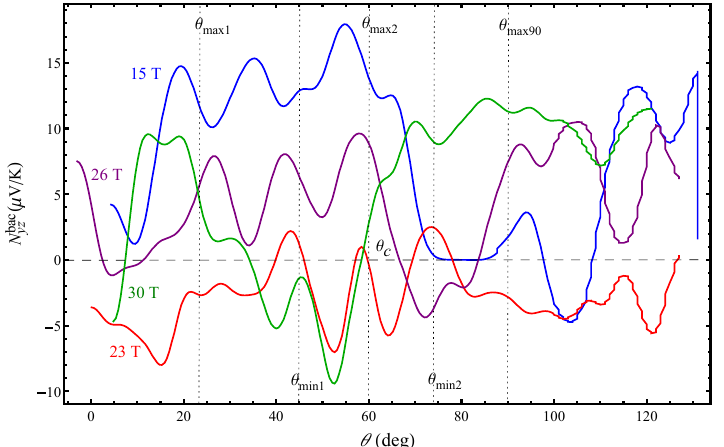
Figure 5. Angular oscillations of the background Nernst effect in α - ( BEDT-TTF ) 2 KHg ( SCN ) 4 for several fields: B = 15 T, 23 T, 26 T, 30 T at T = 0.6 K. The positions of some of the AHRO maxima and minima are indicated by the vertical dashed